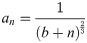
Results obtained for dataset POLY using 10N and 100N observations: A/ process C1 with variable step-size an=1(b+n)23 by varying b, B/ process C1 with variable step-size an=1p(b+n)23 by varying b, C/ process S21 by varying constant step-size a.